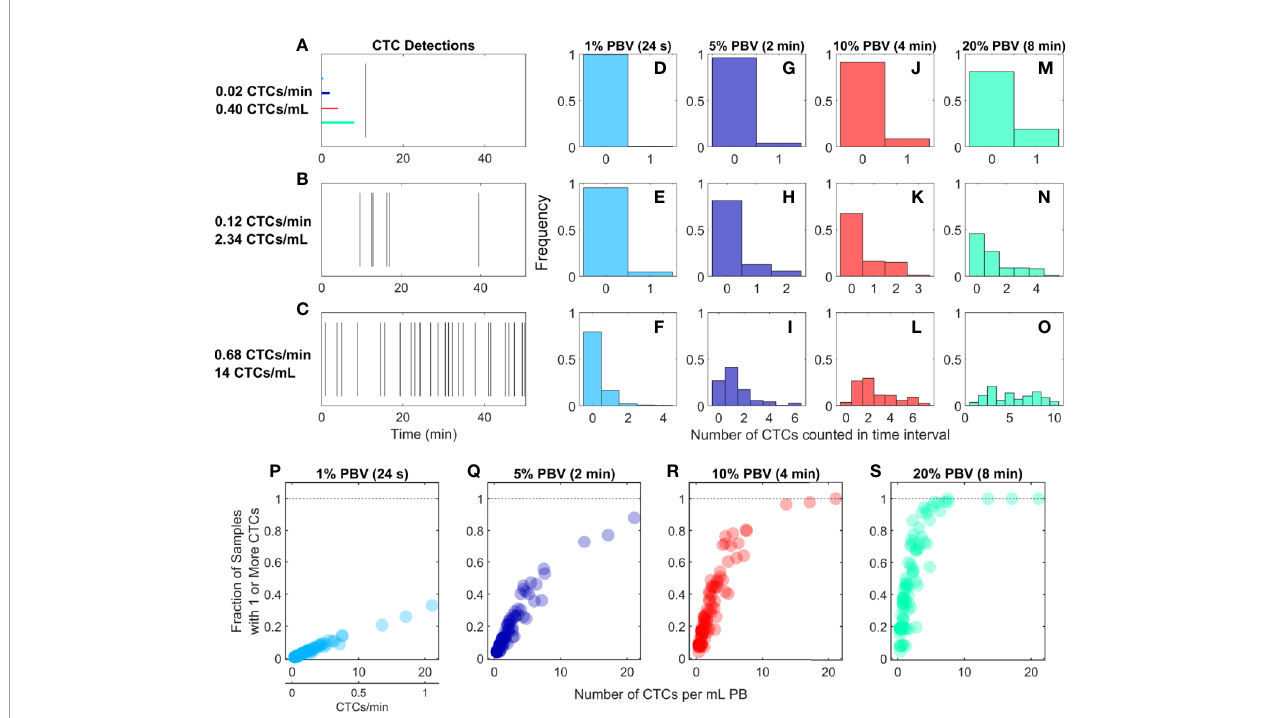
FIGURE 2 | For rare CTCs, small blood samples frequently resulted in no DiFC detections. (A – C) Representative DiFC raster plots of LLC-CTC detections for average count rates of (A) 0.4, (B) 2.3, and (C) 14 CTCs per ml PB. Colored horizontal lines show the relative length of approximately 1% (24 s), 5% (2 min), 10% (4 min), and 20% (8 min) intervals (blood sample size). Distributions of CTC counts in detections intervals are shown for (D – F) 1% PBV, (G – I) 5%, (J – L) 10%, and (M – O) 20% PBV DiFC scan intervals. The fraction of intervals where 1 or more CTCs were detected for (P) 1%, (Q) 5%, (R) 10%, and (S) 20% PBV scan